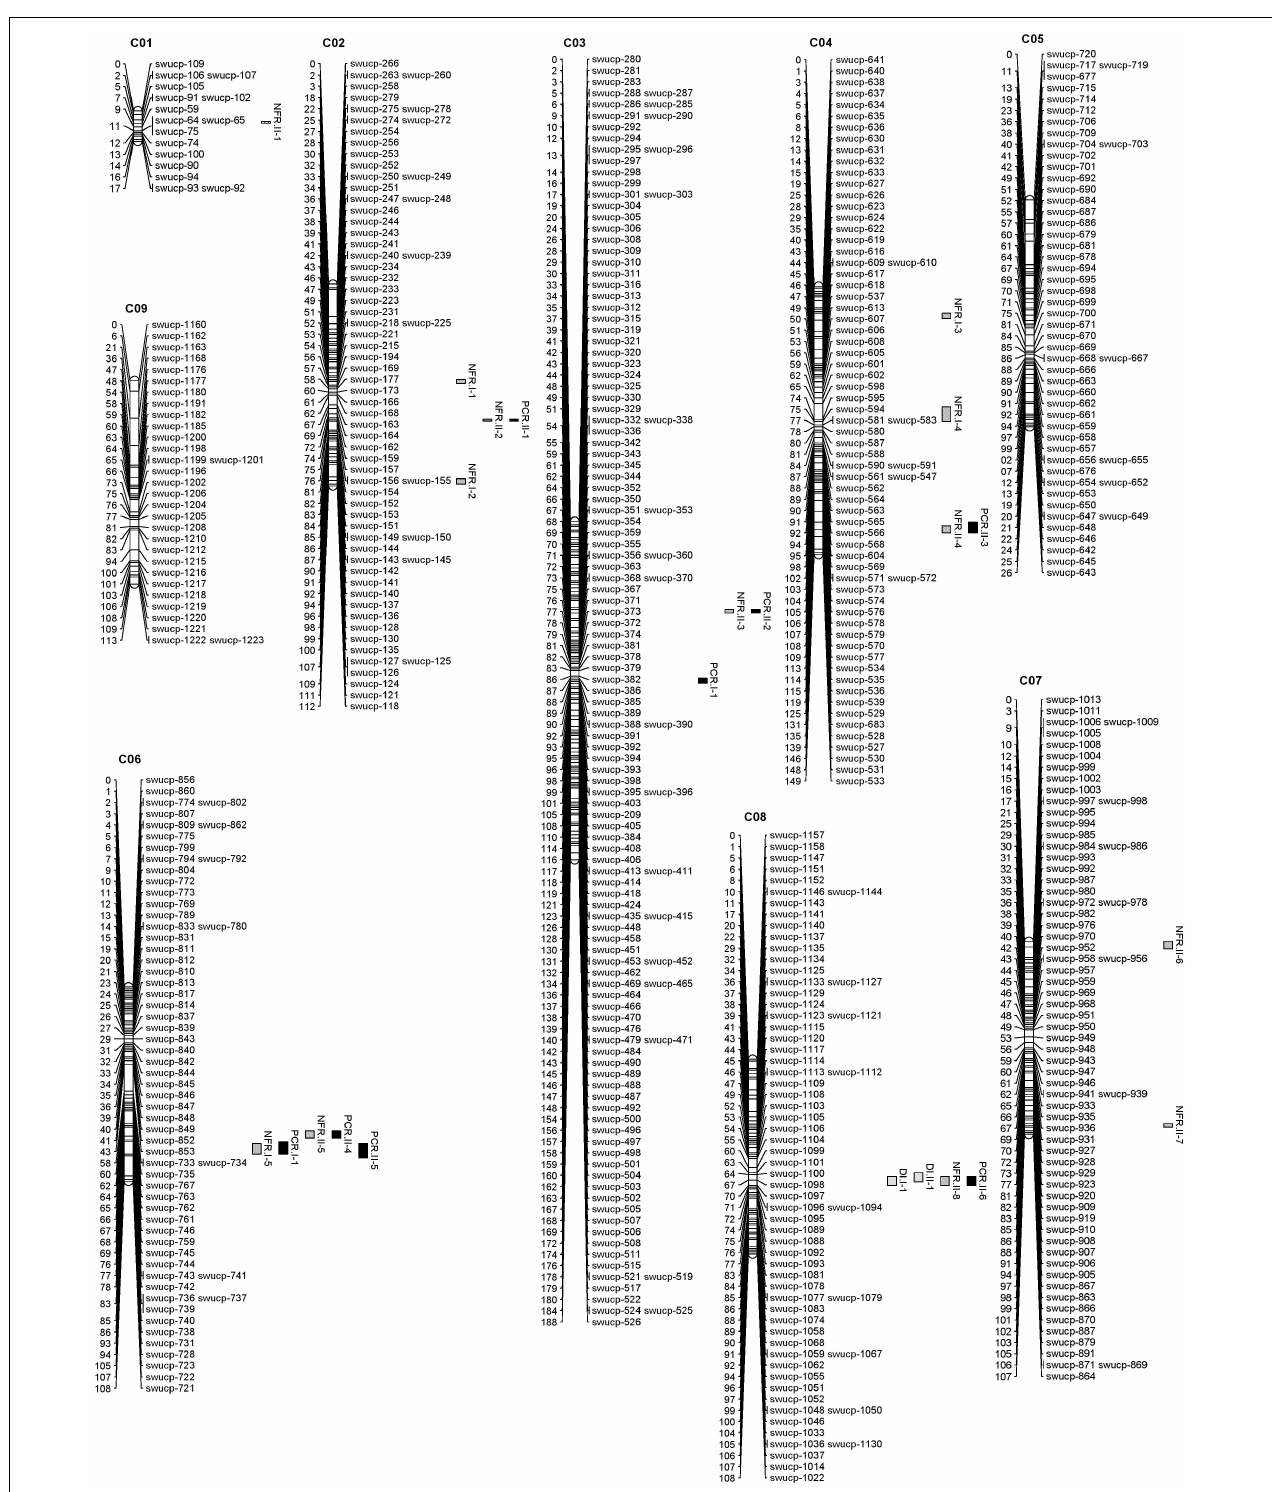
FIGURE 2 | The Brassica oleracea genetic linkage map and quantitative trait loci (QTLs) for disease incidence (DIC), the number of fibrous roots (NFRs), and the P. brassicae content in roots (PCR).